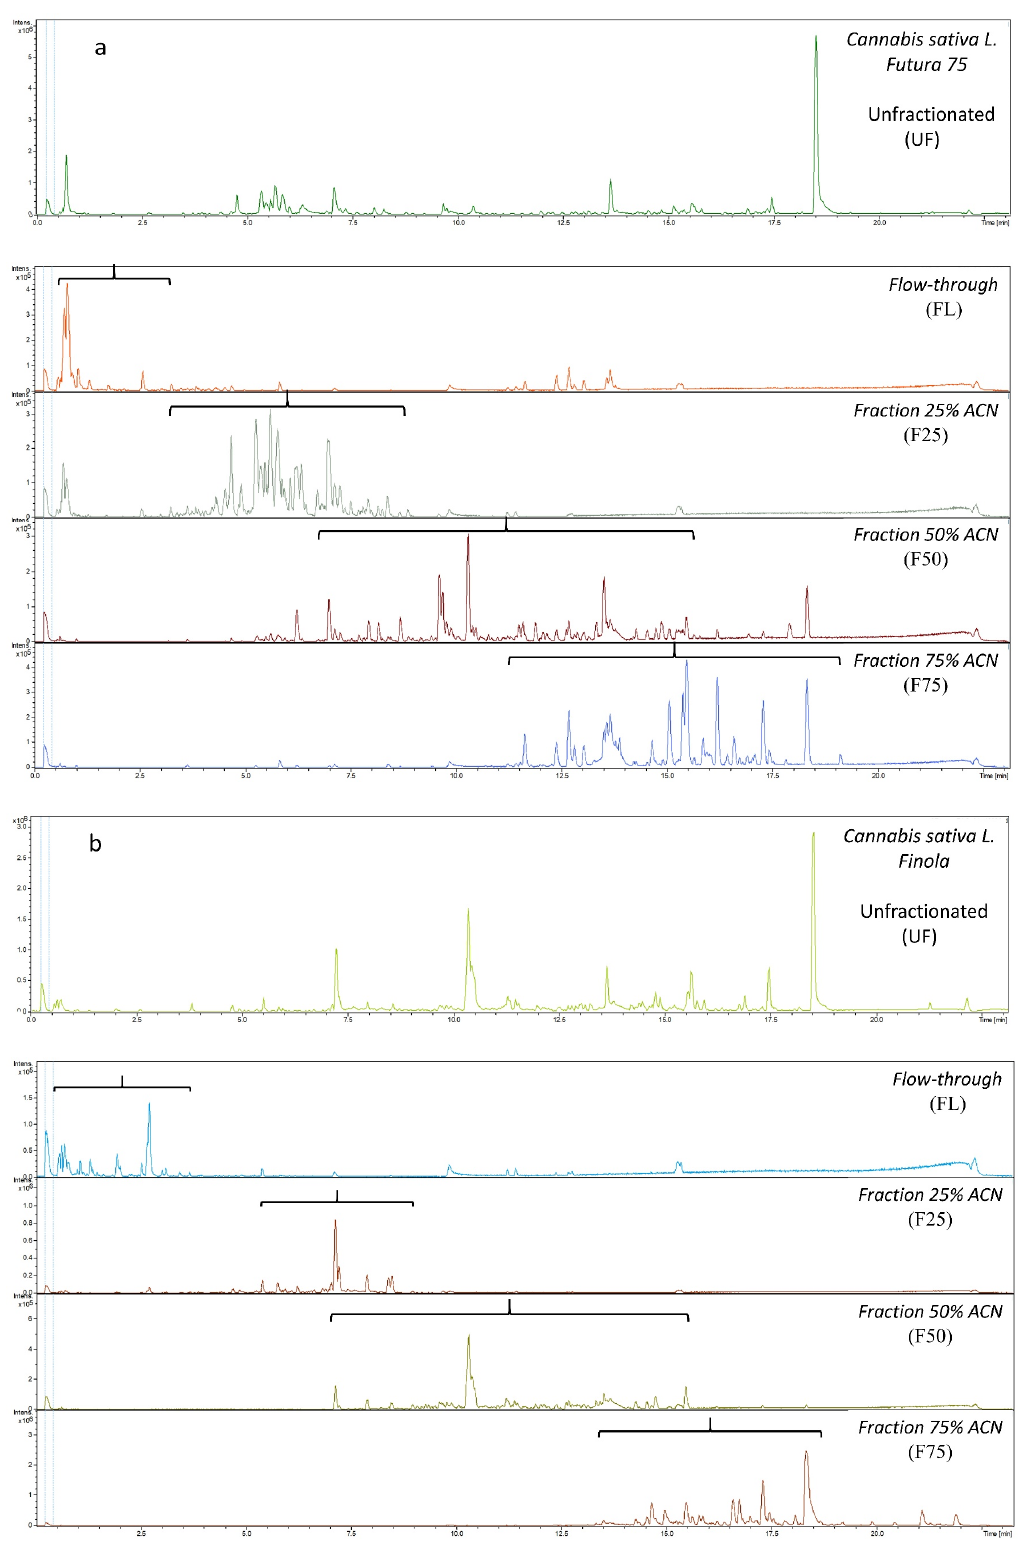
Figure 2. Metabolic profiles using LC-TOF-MS of Cannabis sativa L. Futura 75 ( a ) and Cannabis sativa L. Finola ( b ), unfractionated, flow-through, and fractions 25%, 50%, and 75% acetonitrile (ACN) after evaporation and reconstitution in pure water.